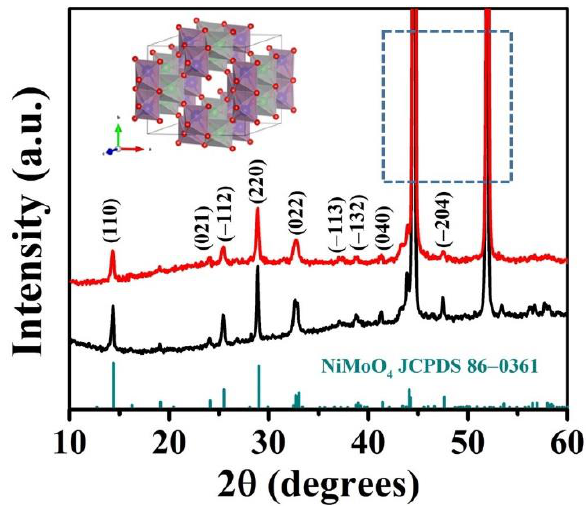
Figure 2. XRD patterns of NiMoO 4 NWAs (black) and NiMoO 4 − x @C composite (red). The inset (top left) shows the structural model of NiMoO 4 crystal, whereas the green, blue, and red balls represent the Ni, Mo, and O atoms, respectively. The two strongest diffraction peaks in the square regions of dotted line are from the ferronickel foam substrate.